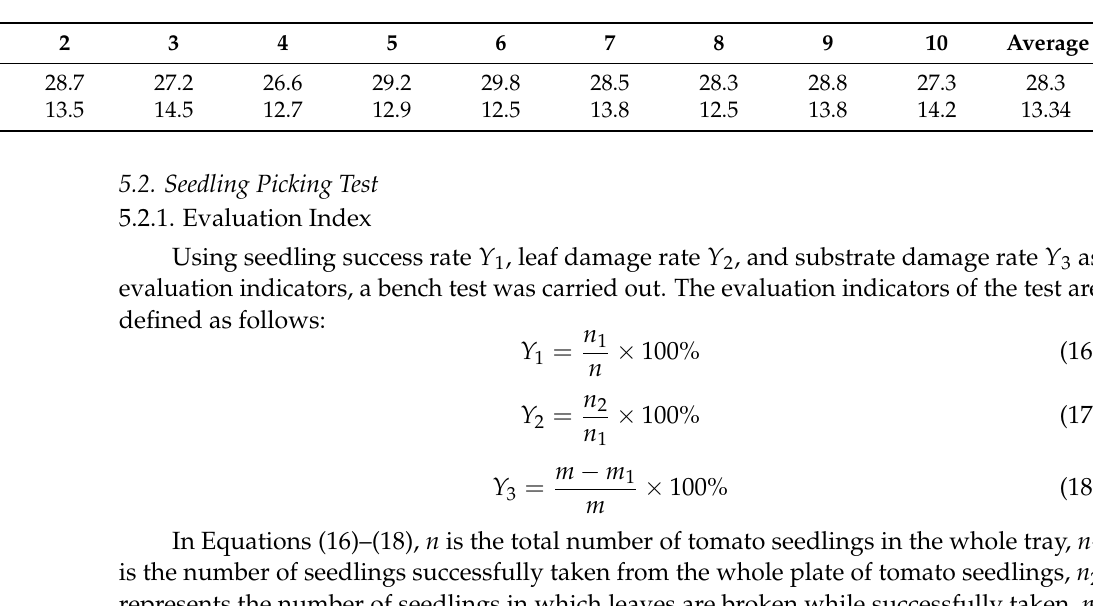
Figure 18. Process of seedling picking and releasing. Table 3. Results of trajectory